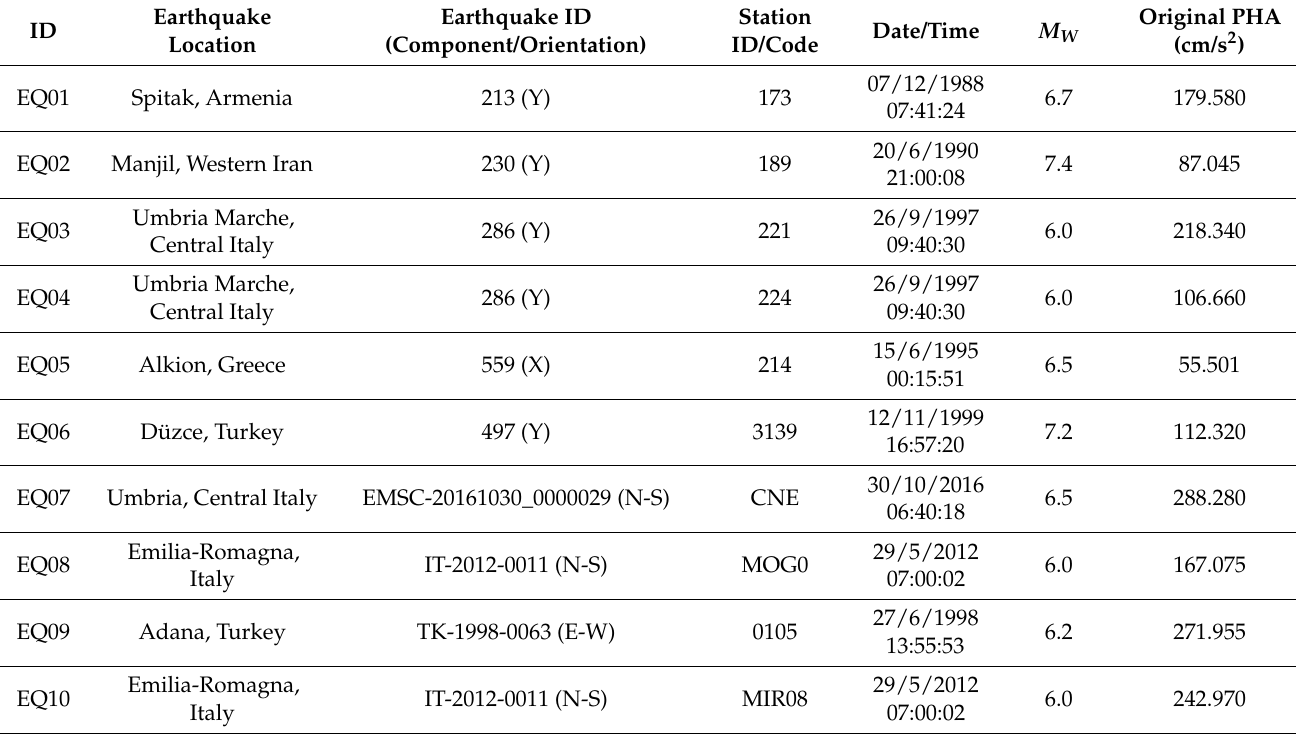
Figure 5. Response spectra used in the analysis (scaled RS i , mean RS and mean scaled RS). Table 1. Main properties of the earthquakes that were used in NDA.